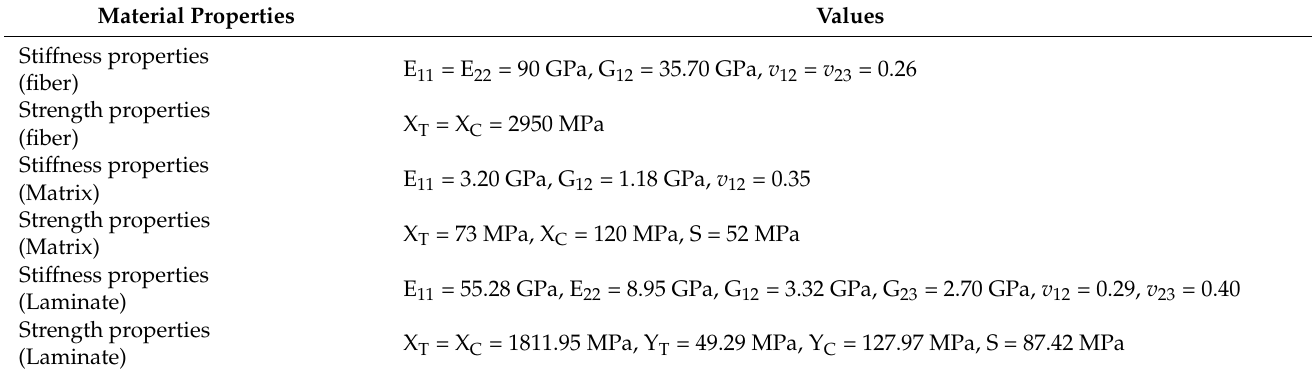
Table 2. Material properties of basalt